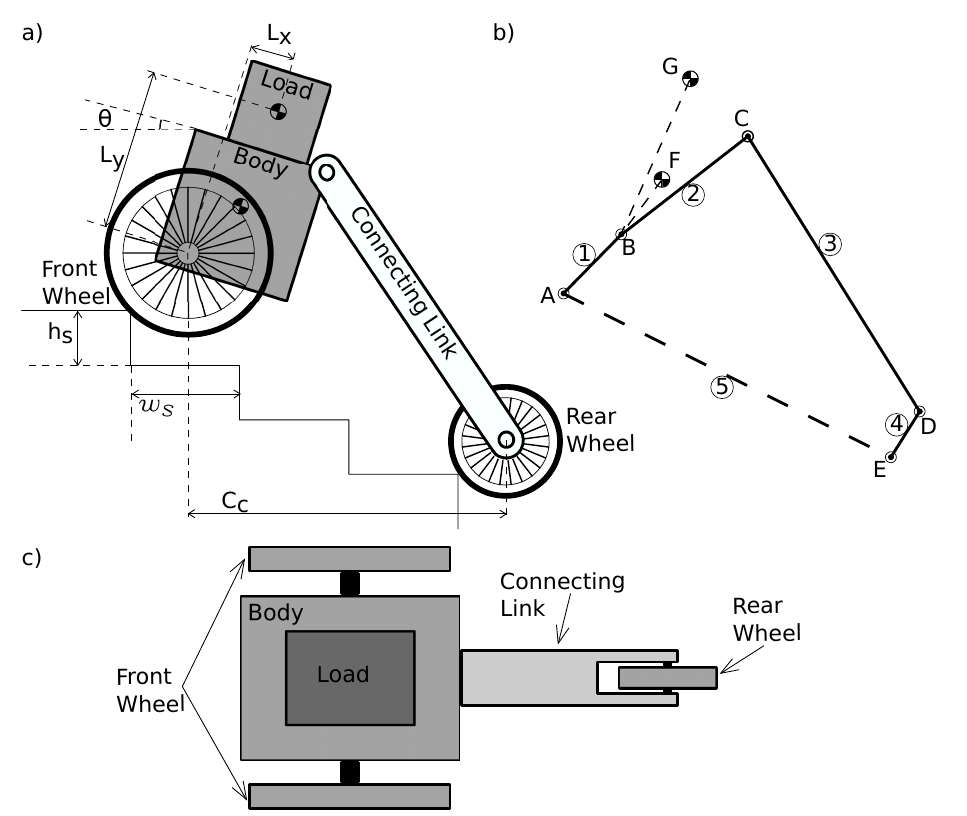
Figure 2. ( a ) A schematic view of the stair climbing robot; ( b ) Robot as a 5 bar linkage mechanism; ( c ) Top view of the robot.